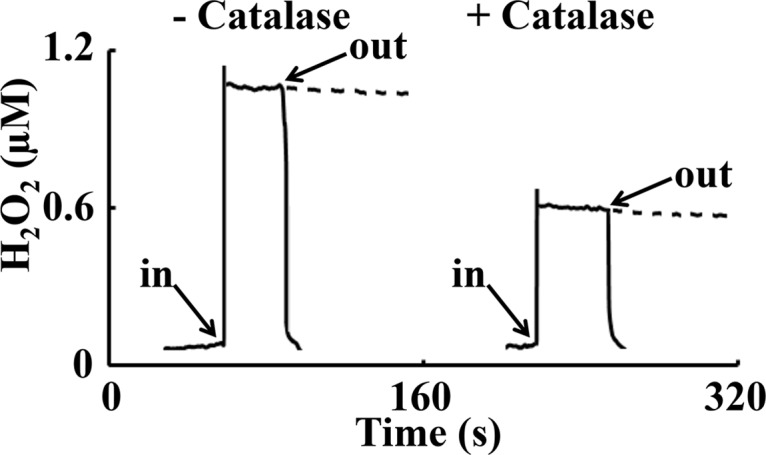
Real-time measurements of intra-oocyte H2O2 concentration utilizing H2O2-selective electrode.With the use of the oocyte media or PBS buffer surface as the “zero point”, the H2O2 electrode tip was inserted directly into the ooplasm. The pic o ampere differences were recorded and the stable intra-oocyte reading was taken as the H2O2 signal. The arrows show the time of insertion and withdrawal from the oocyte. The inset shows the insertion process.